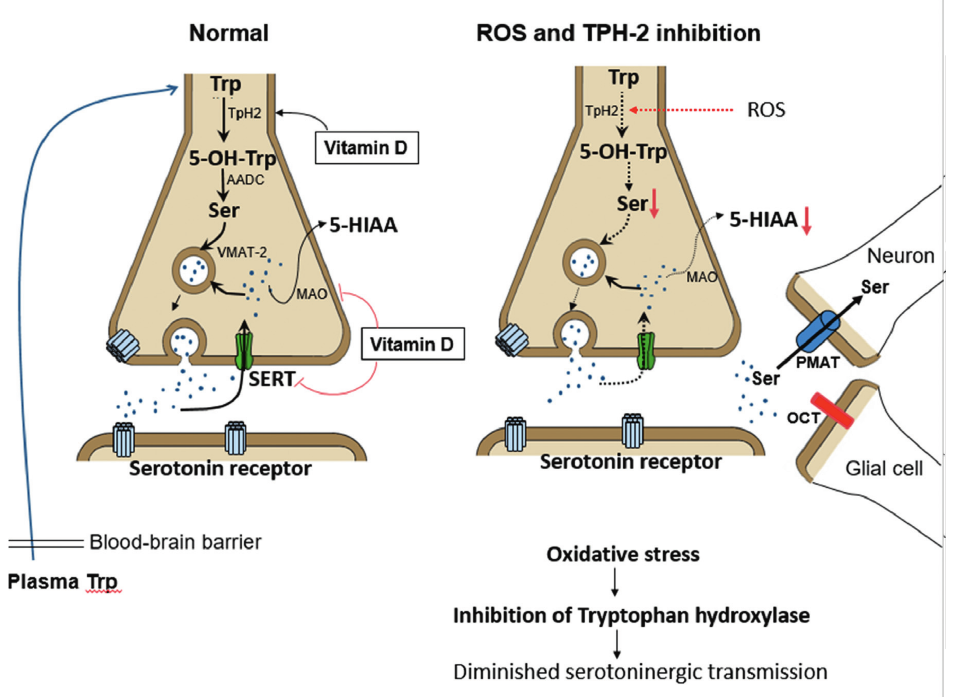
Figure 2: On the left side, the normal intestinal absorption, passage across the blood-brain barrier, and neuronal Trp uptake are shown. Neuronal Trp will be hydroxylated by tryptophan hydroxylase to 5-hydroxytryptophan (5-OH-Trp) and decarboxylated by aromatic amino acid decarboxylase to serotonin, which is then transported by the vesicular monamine transporter (VMAT-2) into presynaptic vesicles. After serotonin releases into the synaptic cleft, part of the serotonin pool will be cleared from the synaptic space by SERTinto the presynaptic compartment where it will be partly recycled into vesicles or catabolized by MAO to 5HIAA. Another part of the synaptic serotonin pool will be taken up by PMAT-expressing neurons or OCT-expressing glial cells. On the right, the findings of this study suggest diverse causes contributing to lowered serotonin turnover. Abundant formation of ROS or peroxynitrite probably represents a major factor involving TPH2 enzyme dysfunction through oxidation of cysteine rich sites at the Trp binding site. In a minority of cases, a low plasma Trp as substrate for serotonin (5HT) production may be due to low dietary Trp intake or malabsorption. Rare genetic mutations of the gene encoding the serotonin reuptake transporter (SERT) lead to a gain of function of serotonin reuptake leading to diminished serotonin availability at postsynaptic receptors. Other rare mutations affect the gene encoding PMAT involving reduced clearance of serotonin from synaptic spaces, thereby disturbing serotonin turnover during early fetal brain